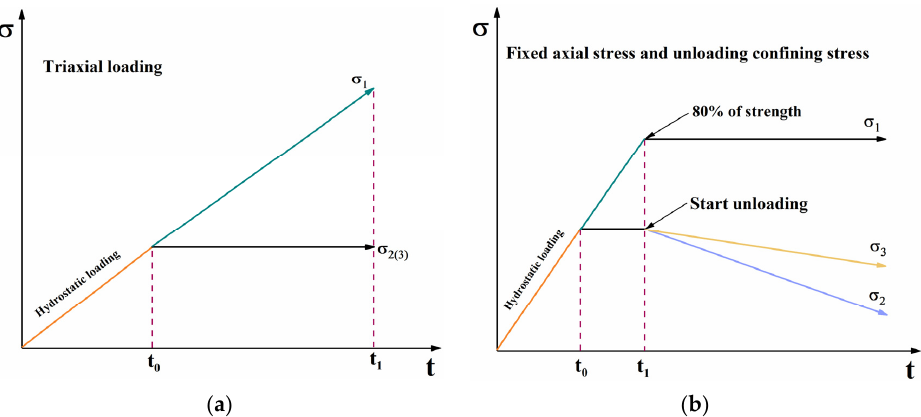
Figure 2. Stress path map. ( a ) Triaxial loading. ( b ) Fixed axial stress and unloading confining stress. Table 1. Experimental conditions of coal samples.